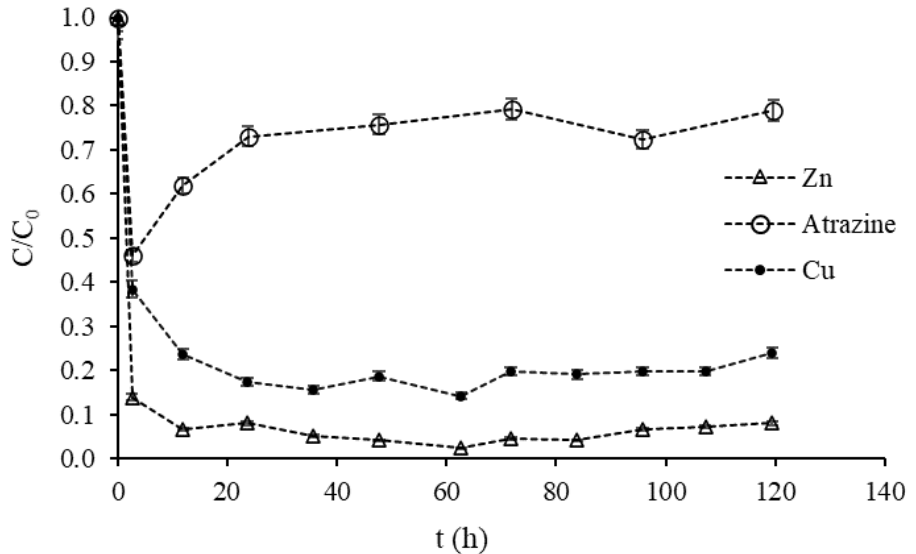
Figure 7. Removal of contaminants over time during the PBR experiment.